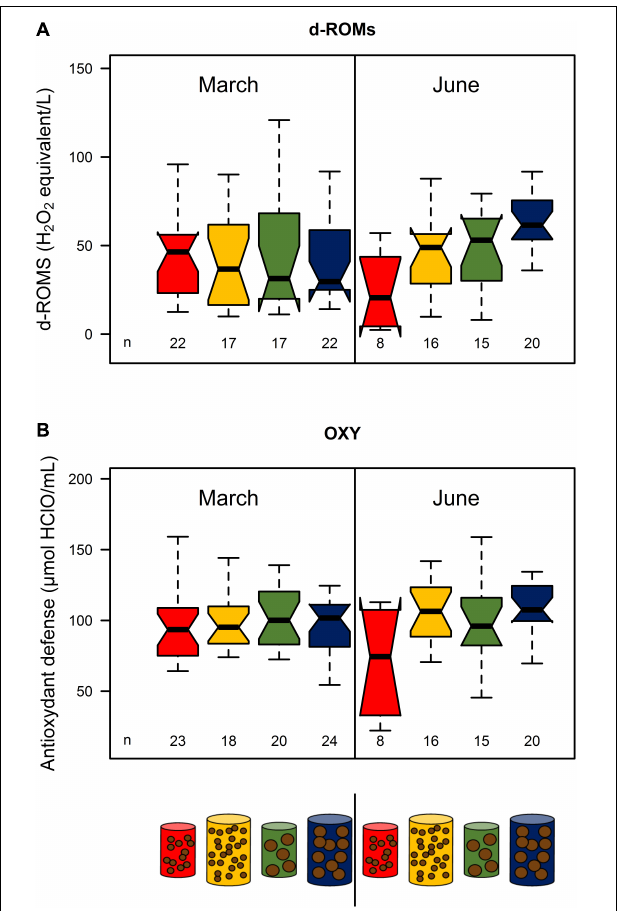
FIGURE 4 | d-ROMs (A) and OXY (B) of the four feeding treatments (red: pellet size of 0.1 mm and pellet quantity 0.3%; green: 0.1 mm and 0.6%; yellow: 1.2 mm and 0.1% and blue: 1.2 mm and 0.6%) in March and June 2017. Sample size for each treatment is given by n below the boxes. Boxplots are presented without outliers for clarity